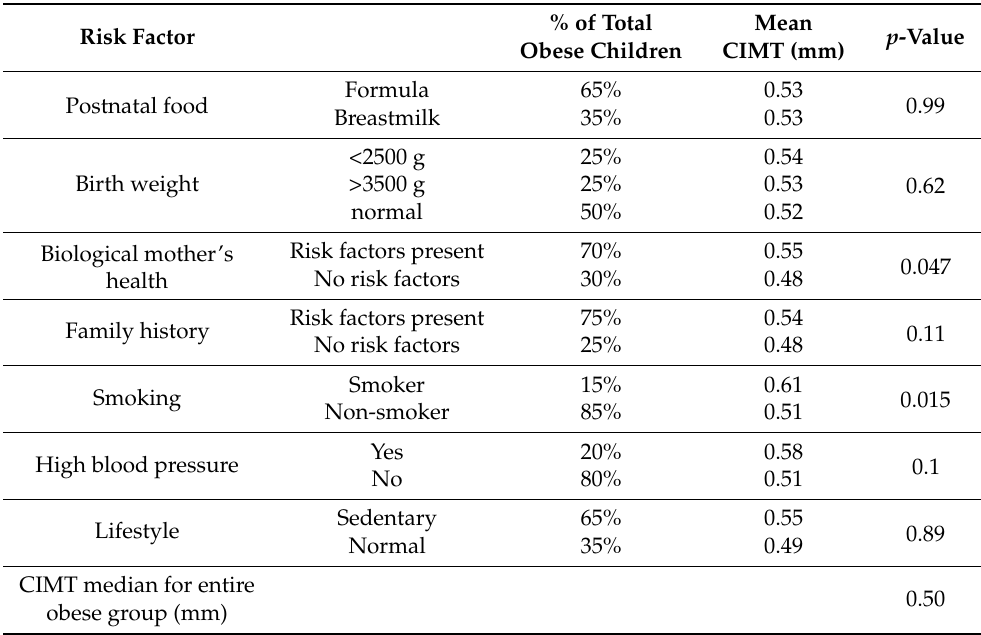
Table 3. Mean CIMT in the presence of different risk factors in obese children. Risk Factor